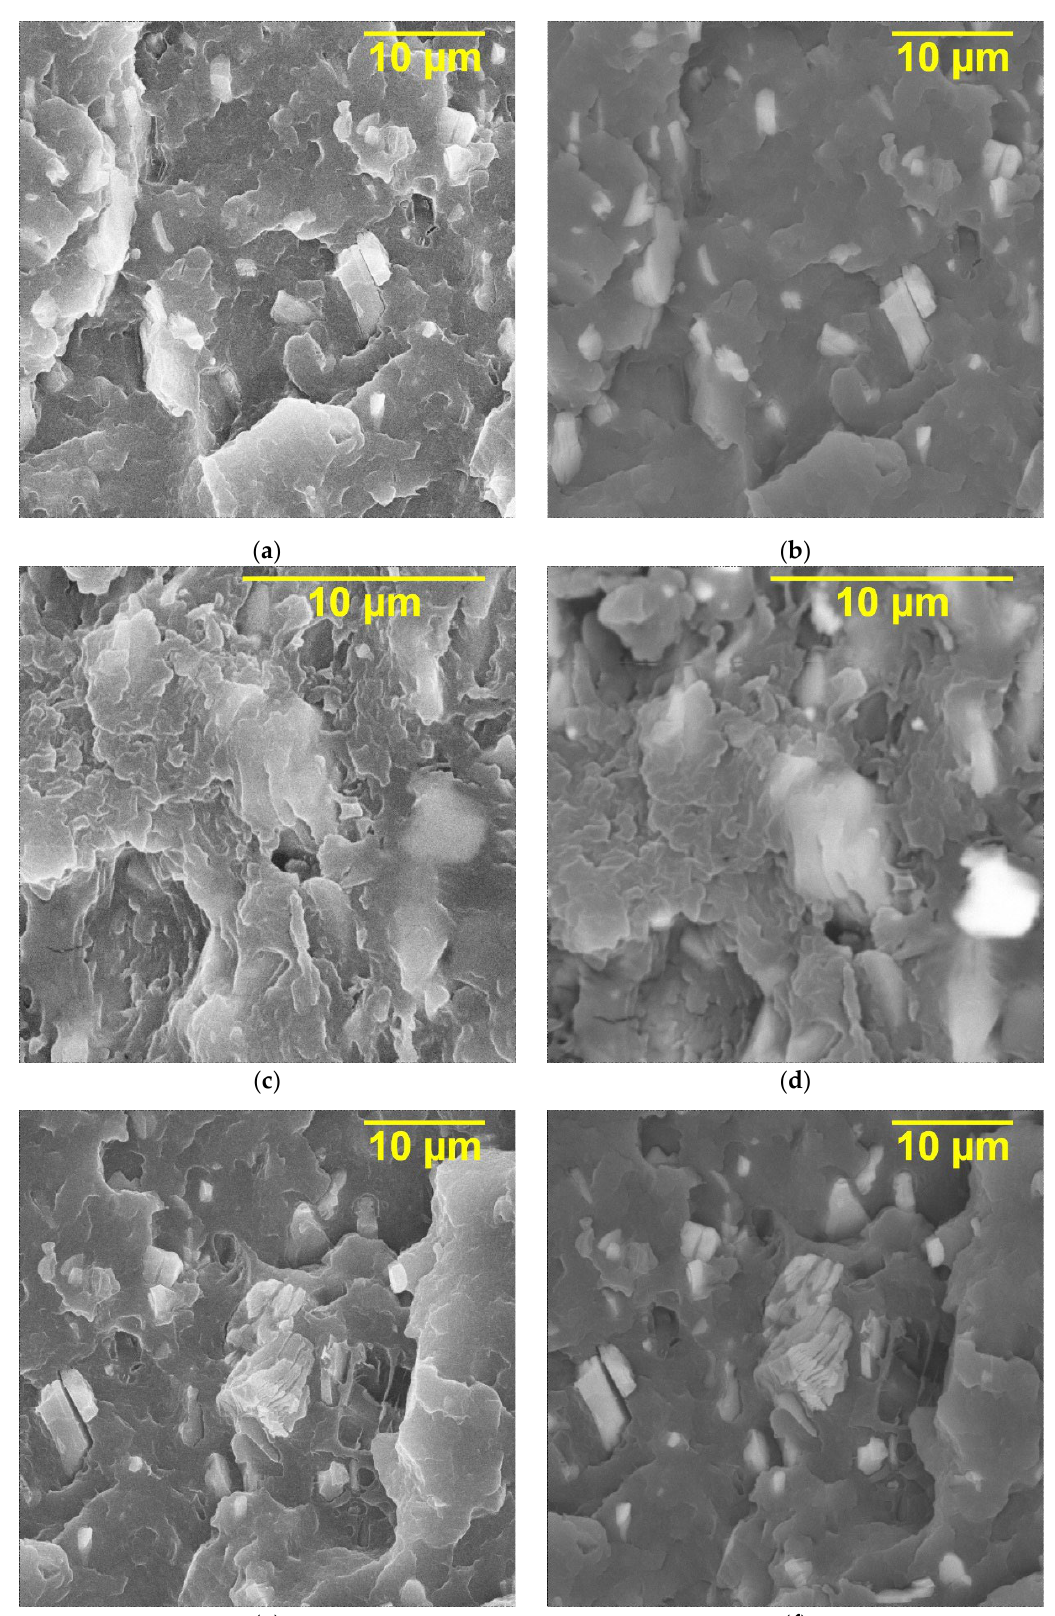
Figure 4. SEM images using primary electrons (left) and secondary electrons (right) of cross sections of ( a , b ) PVDF/Ti 3 C 2 T x , ( c , d ) PVDF/Ti 3 C 2 T x (DMSO), and ( e , f ) PVDF/Ti 3 C 2 T x (urea) with a filler loading of 20 wt.%.